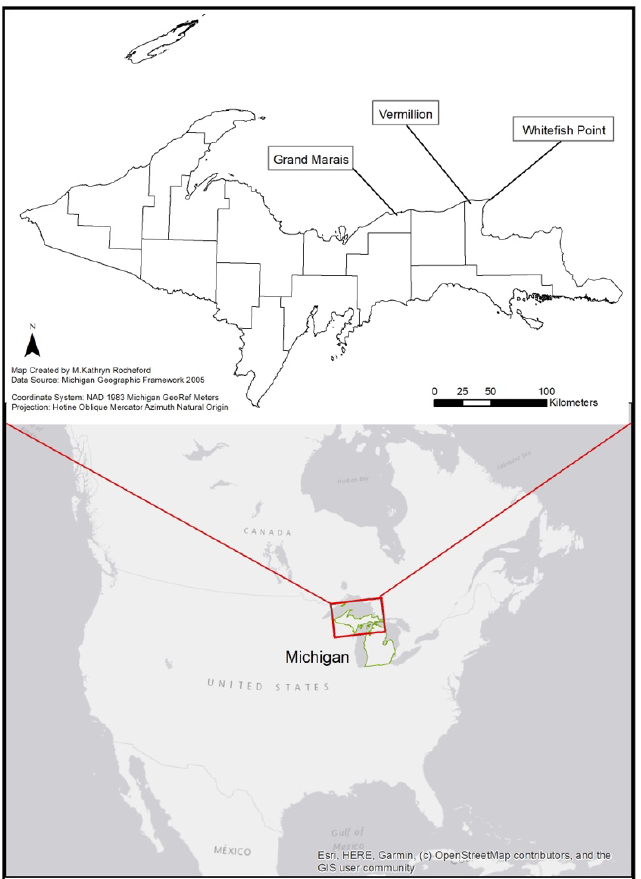
Figure 1. Regional map of North America, highlighting Michigan in green, and showing breeding sites of piping plovers along Michigan’s Lake Superior Shoreline.